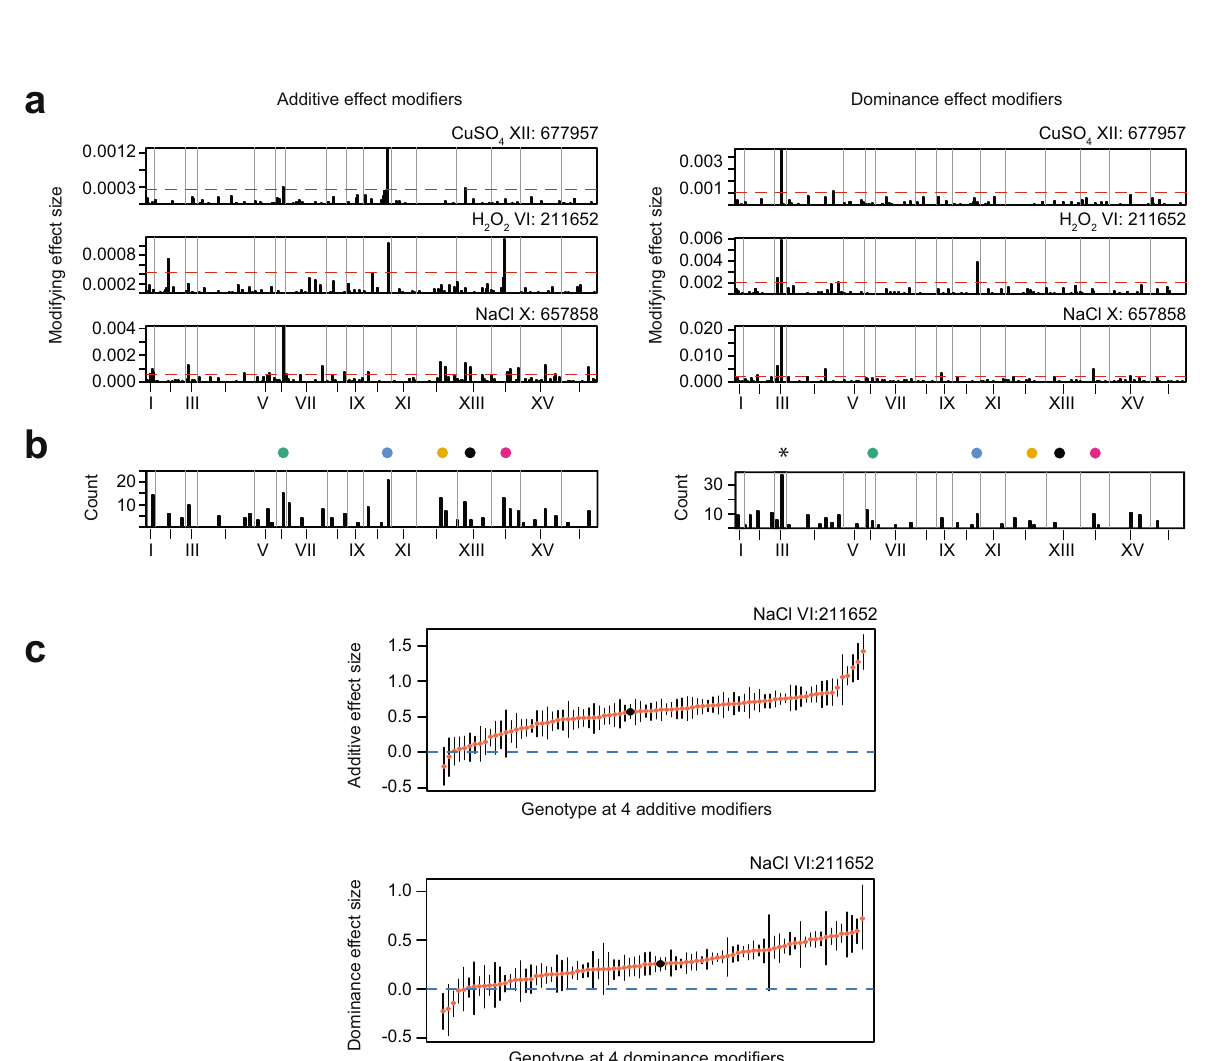
Fig. 4 Multiple modi fi er loci cause hubs to exhibit a range of effect sizes across different genetic backgrounds. a Speci fi c examples of hubs on Chromosome VI, X, and XII (each row) and their additive (left) and dominance (right) modi fi ers. The height of the bar corresponds to the magnitude of the modifying effect. The dotted red line shows the threshold in which loci were considered as major effect modi fi ers. b Barplot showing the total number of times loci were detected as a major effect modi fi er of additive (left) or dominance (right) effects of hubs across environments. Colored dots indicate hub loci. An asterisk indicates a non-hub locus on ChrIII. c Additive (top; n > 443 for each genotype class) or dominance (bottom; n > 175 for each genotype class) effect size of Chromosome VI hub in NaCl across different allelic combinations of its four largest effect modi fi ers. Red points are the mean effect size of a genotype class based on the genotype state of the four modi fi ers. Black point is the overall mean effect size of the locus. Black lines are bootstrapped 95% con fi dence